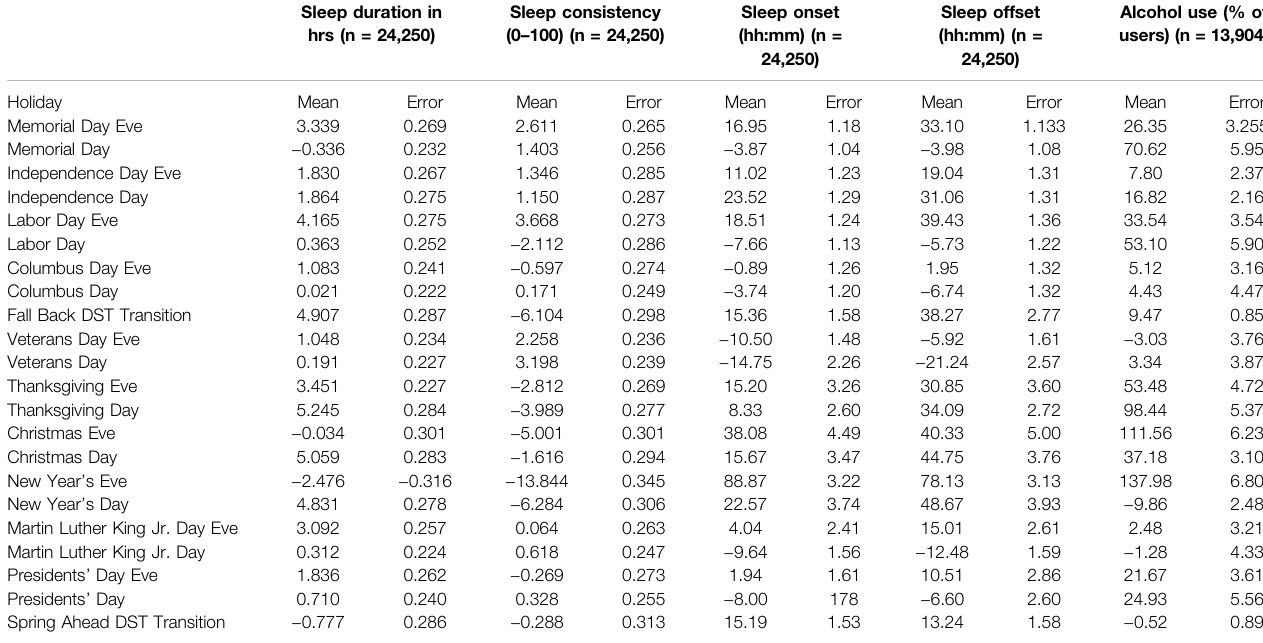
TABLE 1 | Percent change to sleep and alcohol use patterns during DST transitions and on holidays and their eves compared to baseline. Sleep duration in hrs (n =